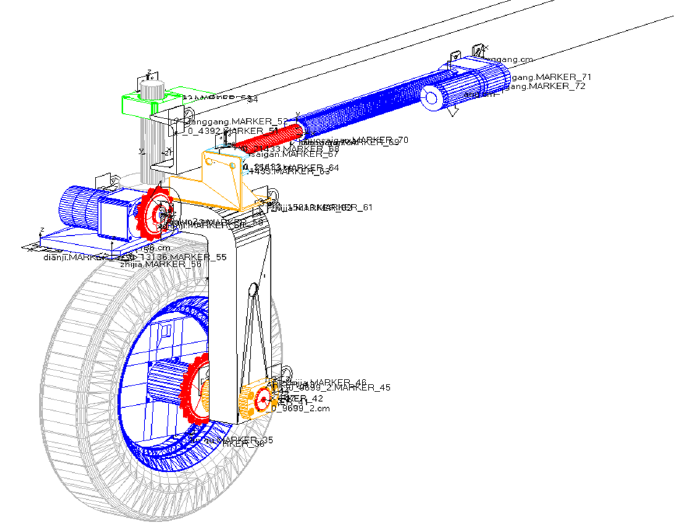
Figure 9. ADAMS simulation model of steering mechanism.